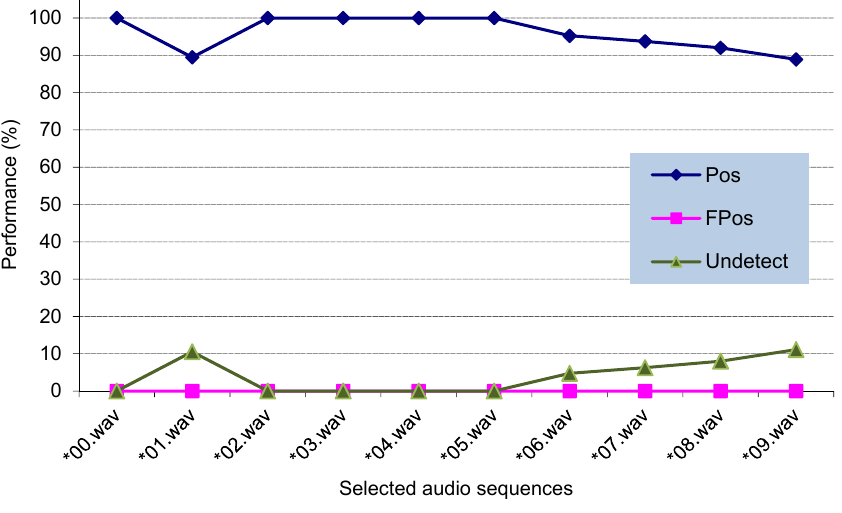
Figure 8. Detection algorithm performance in terms of %Positive (Pos), %False Positive (FPos), and %Undetected (Undetect) performance metrics (Best case